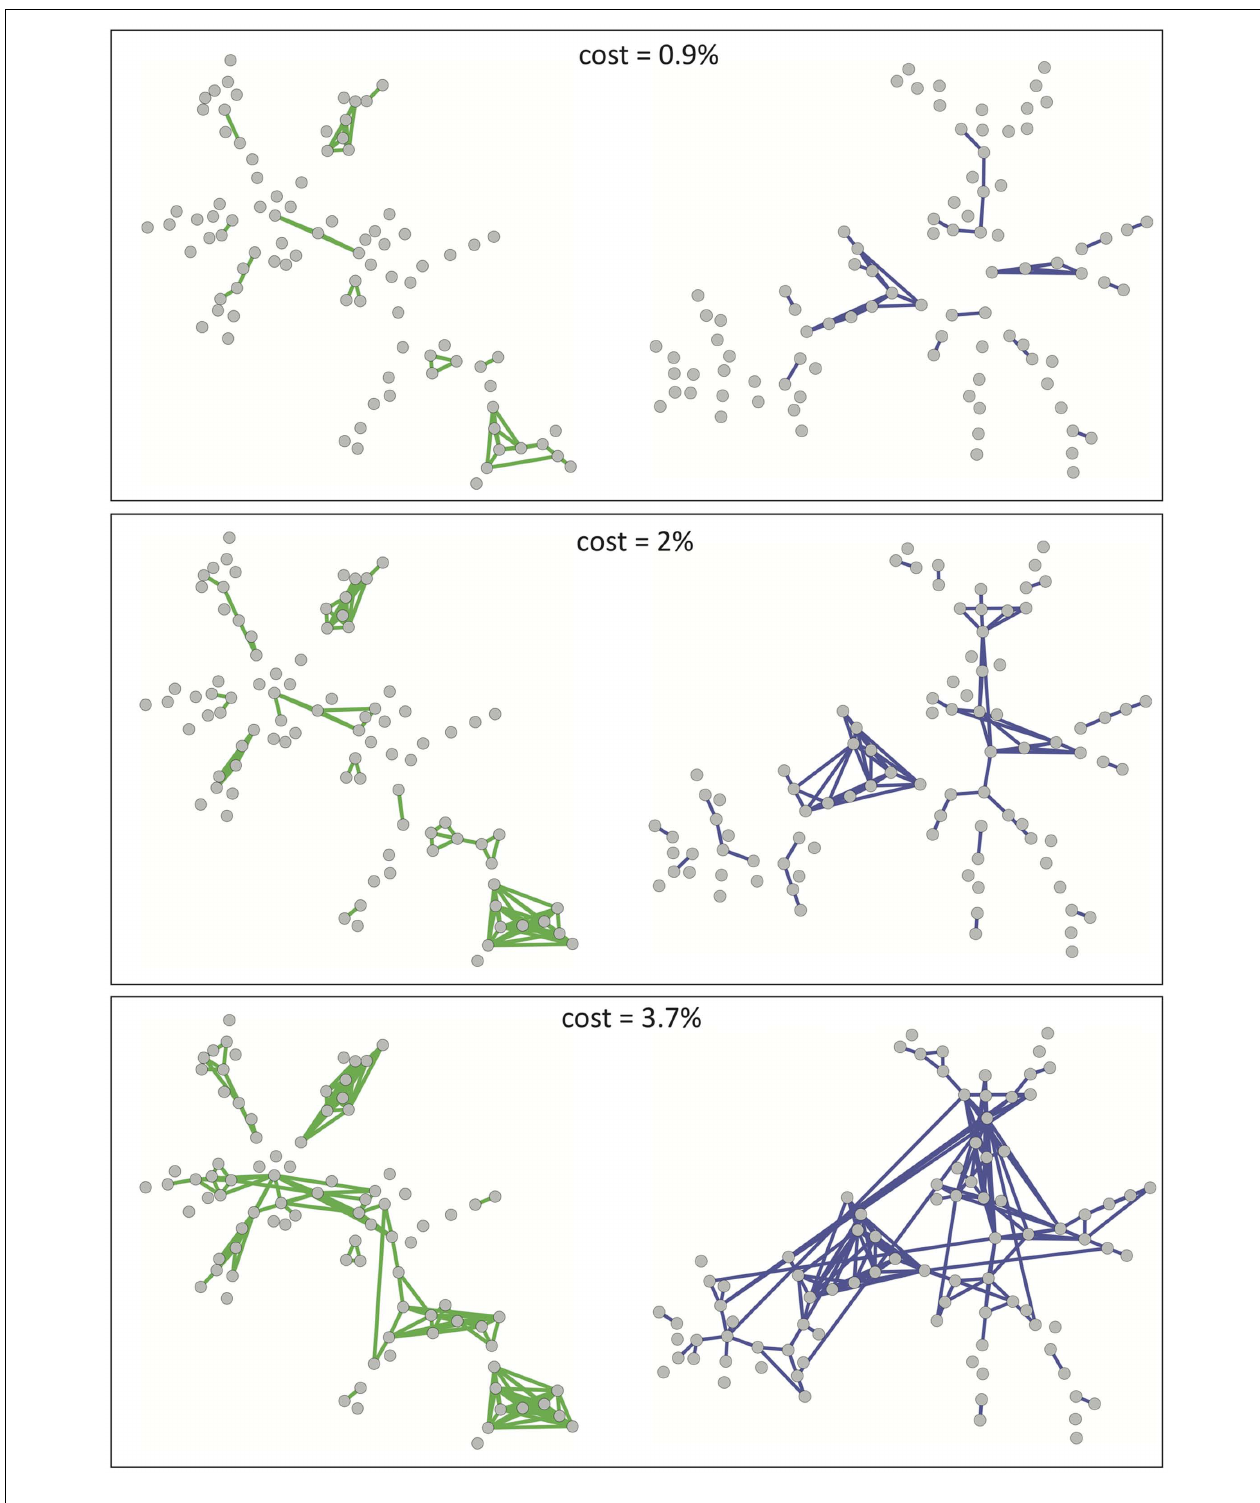
FIGURE 2 |A visualization of the growth of financial and brain graphs as cost is increased. Financial networks are shown in green (left-hand column)